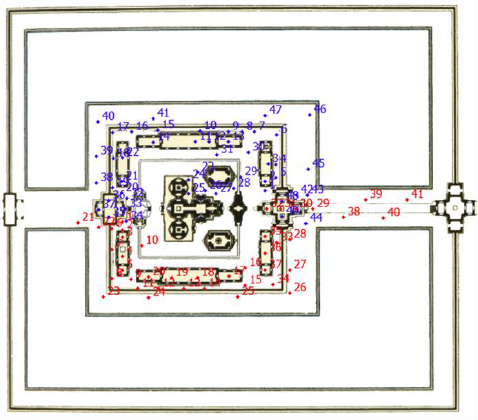
Figure 4. Field survey on 16-18 Aug. 2018